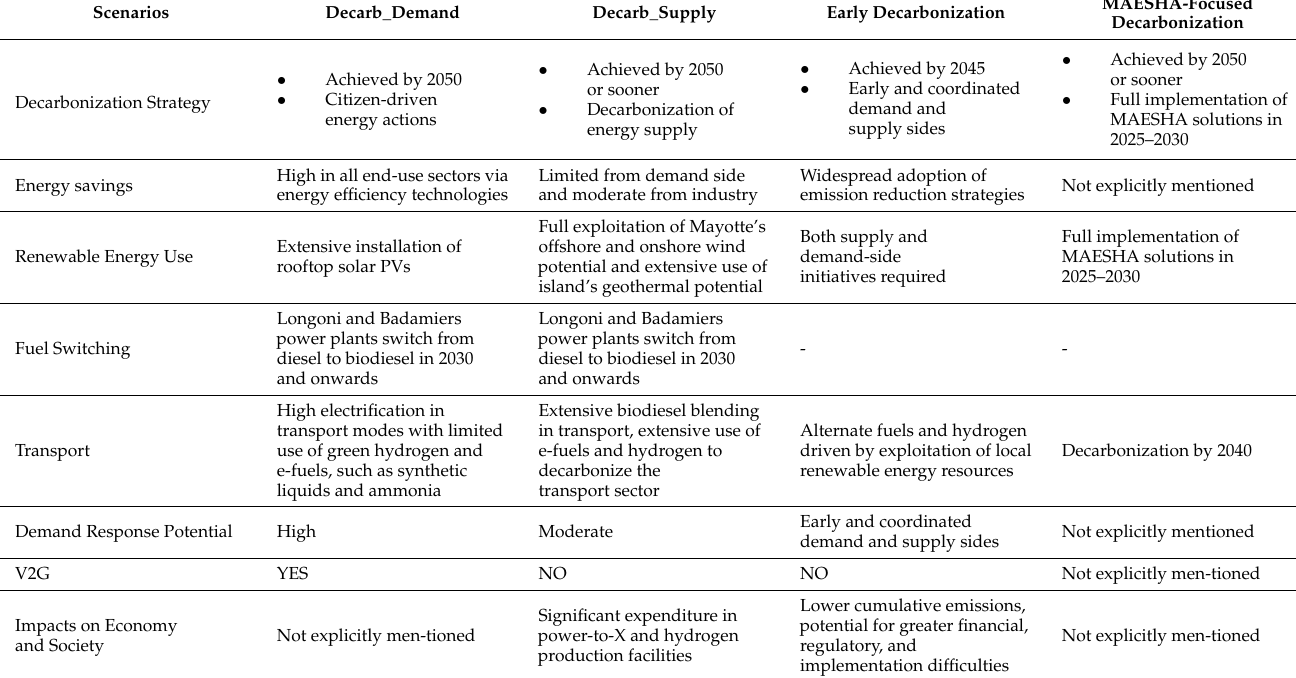
Table 3. Comparison of the four decarbonization scenarios for the island of